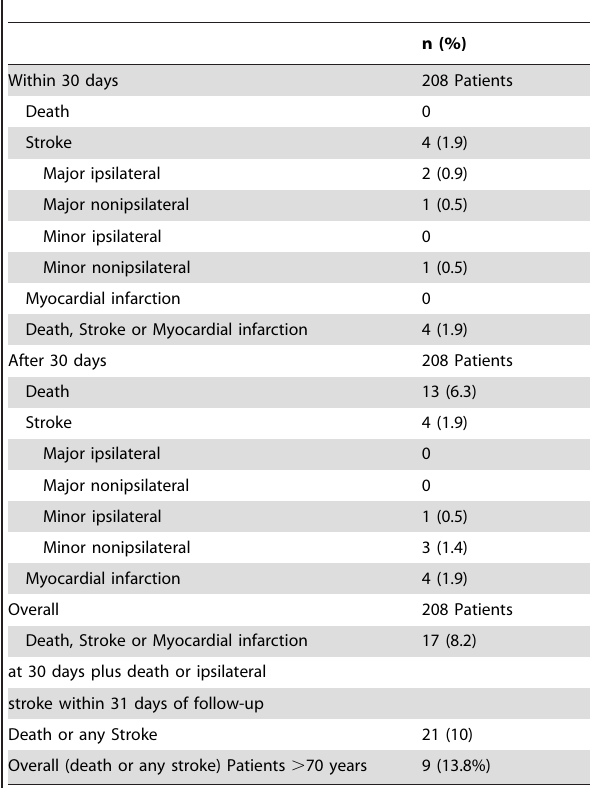
Table 4. Major Adverse